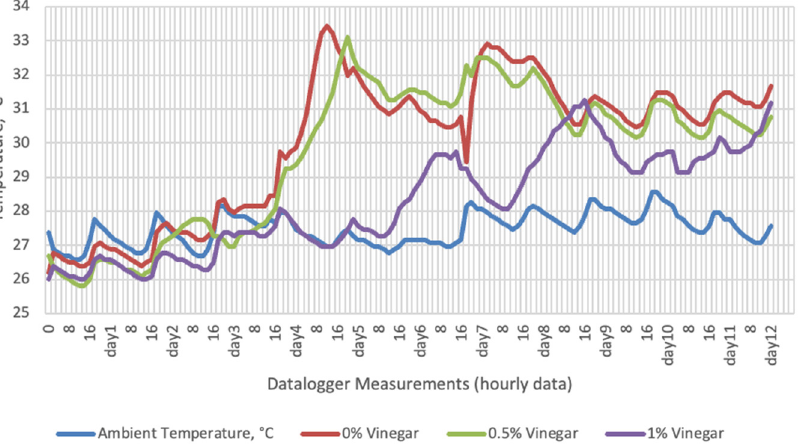
Figure 1. Temperature changes of apple vinegar supplemented groups stored at room conditions for 12 days (Ambient temperatures of room conditions: 27–29 °C; 48% Humidity).